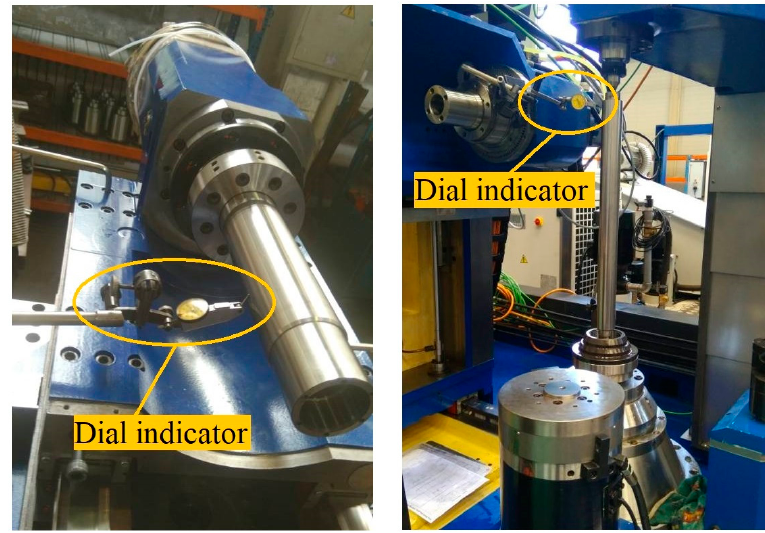
Figure 8. Complete geometric errors of the X-axis and the A-axis.